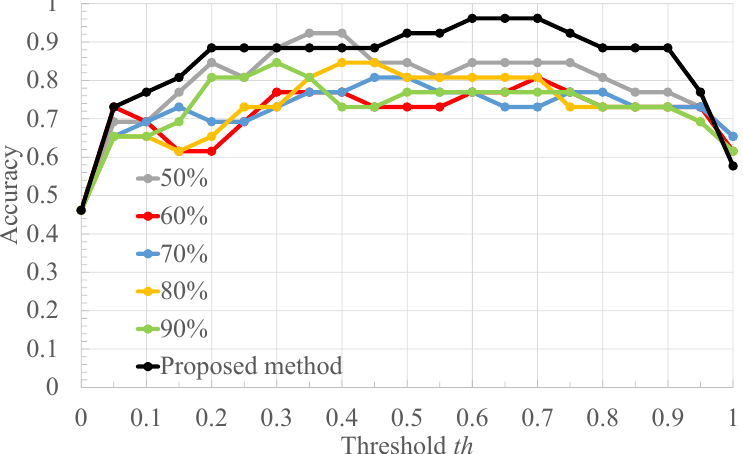
Figure 15. The accuracy of the method based on three-value classification (the percentage classified as moderate RRI = 50, 60, 70, 80, 90%) and the proposed